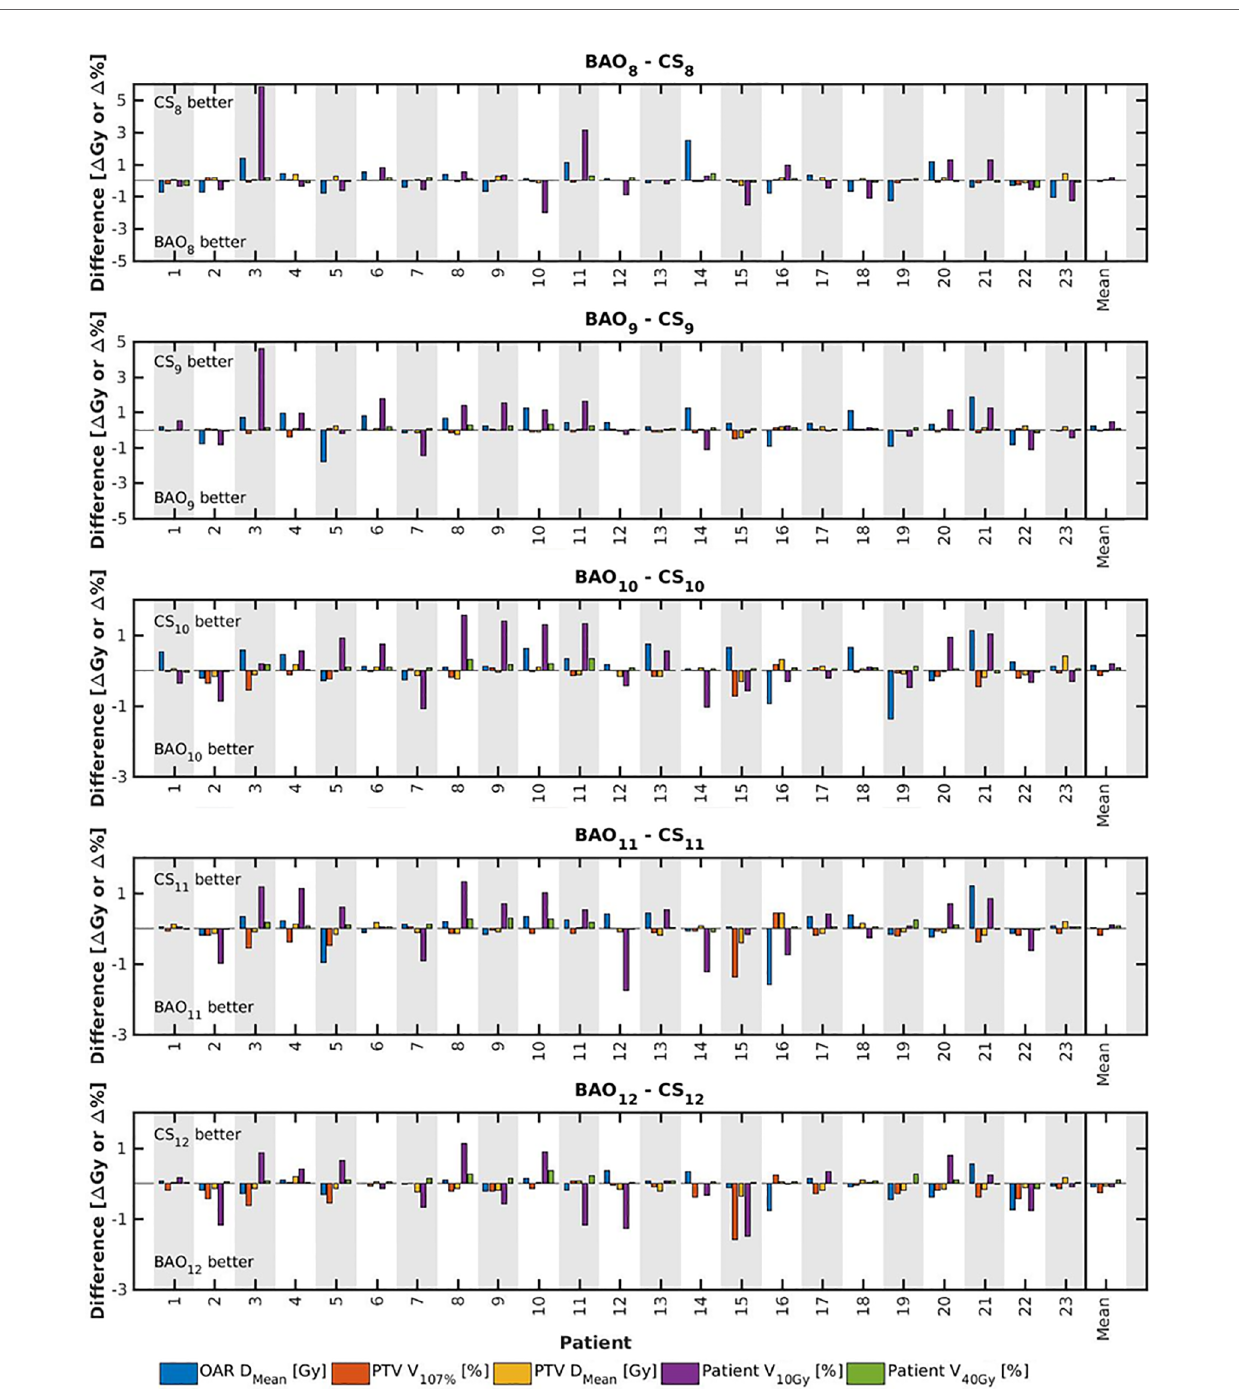
FIGURE 3 | For all patients separately, plan parameter differences between CS x and BAO x for x=8-12 (upper panel) and CS 9 (lower panel). The last columns show population mean differences. Leave-one-out data was used for CS x